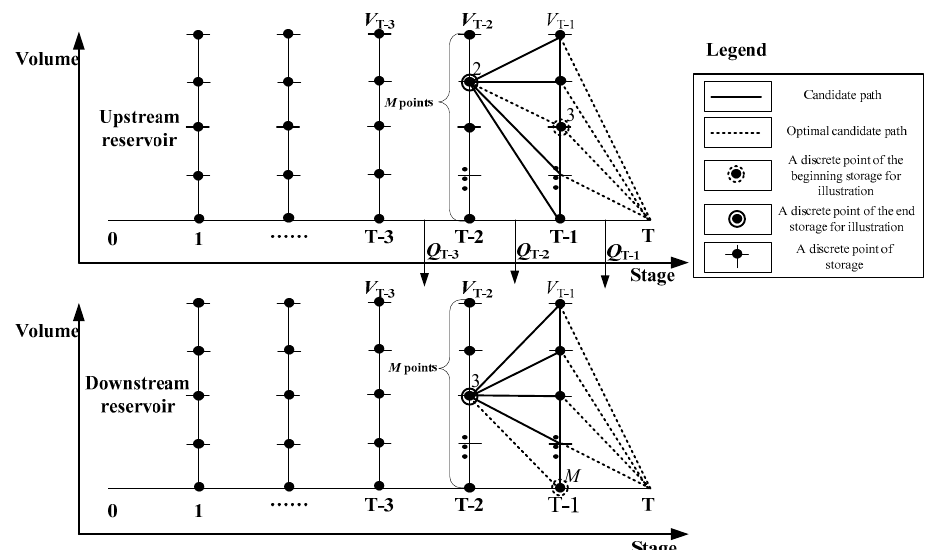
Figure 2. Reverse recursion procedure of multidimensional dynamic programming in solving the cascade reservoirs operation optimization problem.